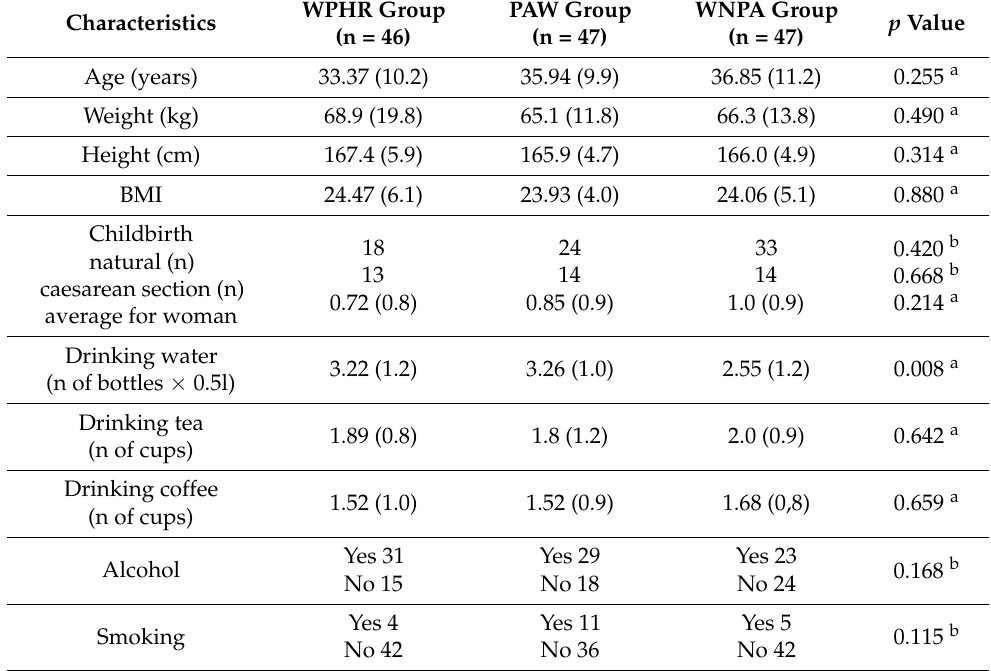
Table 1. Demographic data of the participants.